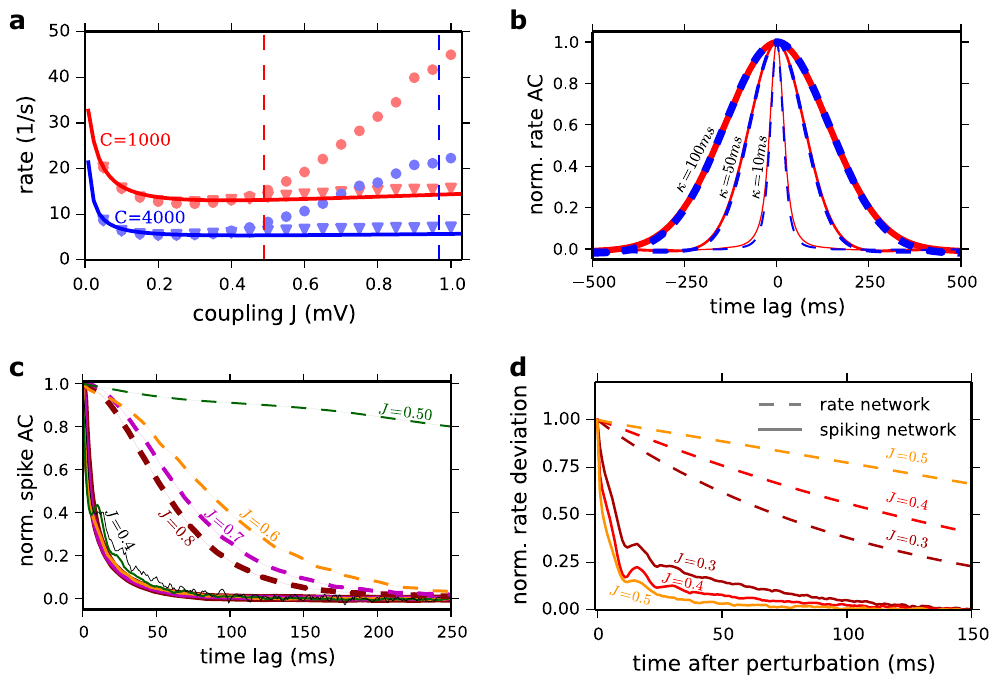
Figure 1. ( a ) Population averaged firing rate in the network vs. coupling strength J. Solid lines: Ricciardi mean field for C=1000 (red) and C=4000 (blue). Predictions for J (Equation 16) are indicated by the corresponding dashed vertical lines. Simulation results (event-based c simulation implemented in Julia programing language) are also plotted. Dots: Δ =0.55 ms synaptic delay. Triangles: Δ =0.0 ms. Results for C=1000, N=10000 (red marker) and C=4000 and N=40000 (blue marker). ( b ) Averaged normalized AC of neuronal rate functions for J= 0.8 mV and C=1000 (red) and C=4000 (dashed blue) LIF networks. The rate functions were computed by filtering the spike trains of the neurons (1 ms time bin) with a Gaussian filter with 10 ms (the thinnest lines), 50 ms (moderated lines) and 100 ms (the thickest lines) standard deviation. ( c ) Autocorrelation function of the spike trains (no filtering) normalized to the second pick. Solid lines: LIF network. Dashed lines: Poisson network. The results are shown for J = 0.5 mV (dark green), J=0.6 mV (dark orange), J = 0.7 mV (magenta) and J=0.8 mV (dark red). For the LIF the AC is also shown for J=0.4 mV (solid black). To compute the ACs for the Poisson network we simulated a network for 100 s (time step 1 ms) and averaged the results over 40 realizations of the initial conditions. The network size is N=100000 for 0.5 ≤ J ≤ 0.6mV and N=10000 for J>0.6 mV. For the LIF network we averaged spike autocorrelation of 3000 randomly chosen neurons with a 1 ms bin following Equation 23 in the paper. All parameters are as in Figure P3. ( d ) Subcritical behavior of the systems. Rate network and spiking network are both perturbed in the constant feed-forward input current µ in the least stable direction of the linearized rate dynamics (Equation 16) for 0 different coupling strengths J. The resulting rate deviation is projected onto the perturbation direction. Dashed lines reflect the normalized decay of this perturbation in the rate network and the solid lines those of the spiking network (averaged over 1.42 million perturbations). The perturbation was applied to the constant feed-forward input µ for 2 ms where the standard deviation of the perturbation vector was 1 mV. 0 Longer perturbation durations (10 ms) and weaker perturbation strengths (standard deviation 0.1 mV) gave very similar results (not shown). Perturbation direction, strength, duration and network realization were exactly the same for rate and spiking network. Other parameters as in (Ostojic, 2014).